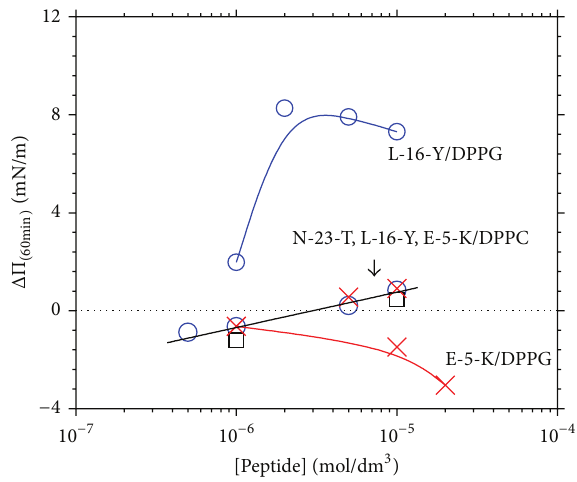
Figure 8: Effects of penetration of the different peptides to DPPC and DPPG monolayers on surface pressure ( Π ); The ΔΠ values measured under the stationary diffusion conditions after 60min. contacts are plotted as a function of logarithm of peptide concen- ) of DPPC monolayers was tration. The initial surface pressure ( Π init in the range of 27.3 ± 0.3 mNm −1 and of DPPG—30.3 ± 0.3mNm −1 (typical of density of biomembranes). The straight line corresponds to linear fit of the penetration effects of the three peptides to DPPC = 𝐴 + 𝐵 × log [ Peptide ] monolayer: ΔΠ (60 min ) = Π (60 min ) − Π init with 𝐴 = 7.22 ± 0.75 mNm −1 and 𝐵 = 1.30 ± 0.13 mNm −1 per decade of the peptide’s concentration ( 𝐴 is of no physicochemical sense, since the results cannot be extrapolated to the extremely low concentrations). The error bars for ΔΠ ( ± 0.5mNm −1 , at maximum) and for concentration ( ± 5%), omitted herein for the sake of lucidity, correspond to diameter of the point